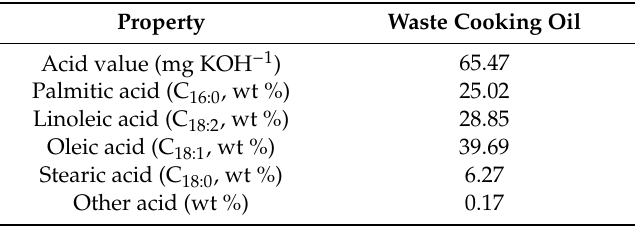
Table 4. Chemical and physical properties of waste cooking oil.